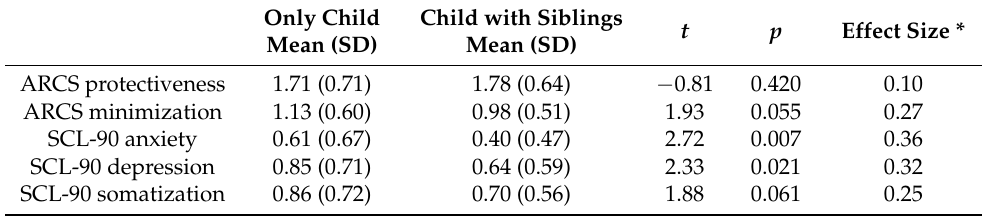
Table 3. Maternal protectiveness, minimization, and distress as a function of only child